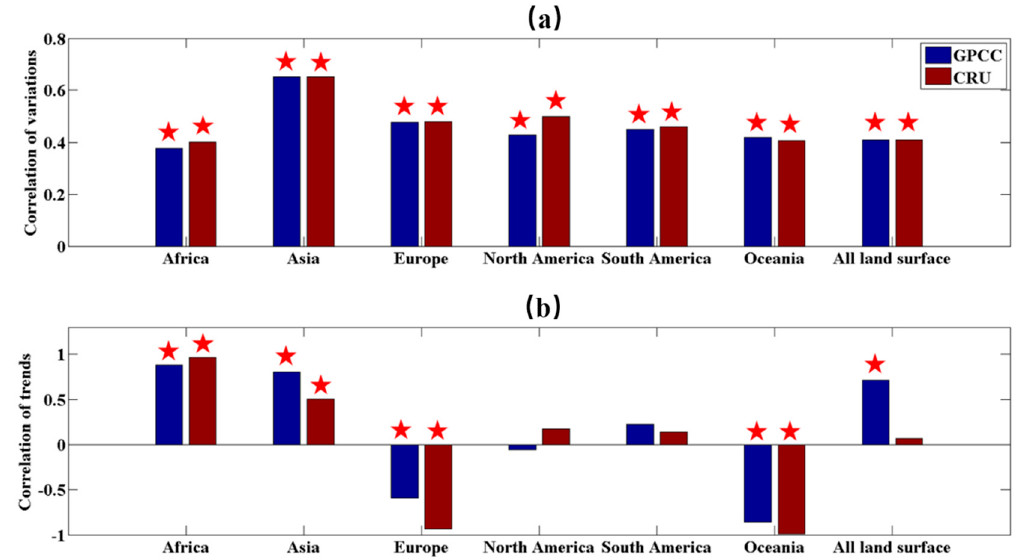
Figure 4. Correlations of ( a ) the detrended time series of annual precipitation and discharge from 1948 to 2004; ( b ) the trends of precipitation and discharge from 1948 to 2004; the red star represents significant correlation at the 95% level.